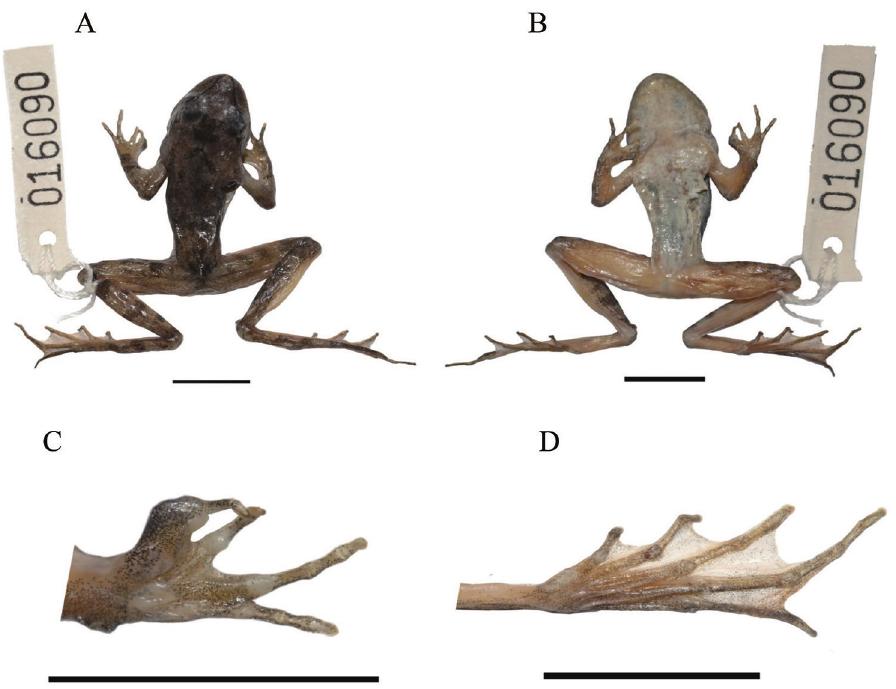
Figure 4. Holotype (KIZ016090) of Rana luanchuanensis sp. n. A Dorsal view B Ventral view C Details of left hand showing the nuptial pad D Details of left foot showing the extent of webbing. Scale bar 10